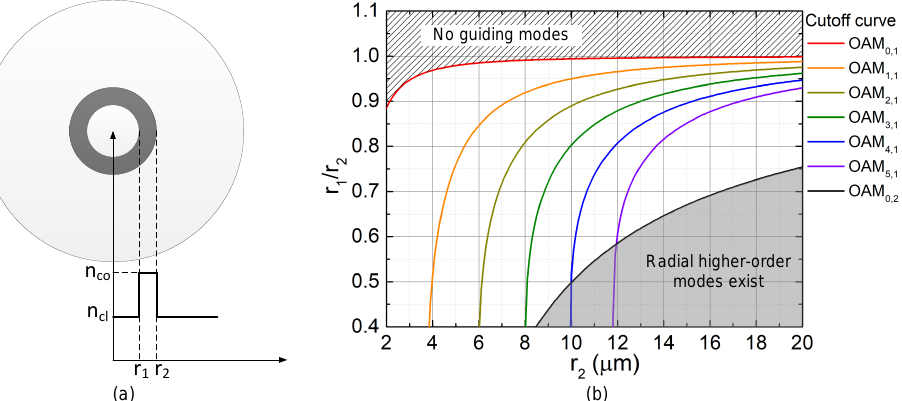
Figure 5. ( a ) The refractive index profile of RCF and ( b ) the cutoff conditions of different order OAM mode groups when ( n co − n cl ) / n co = 0.6% at the wavelength of 1550